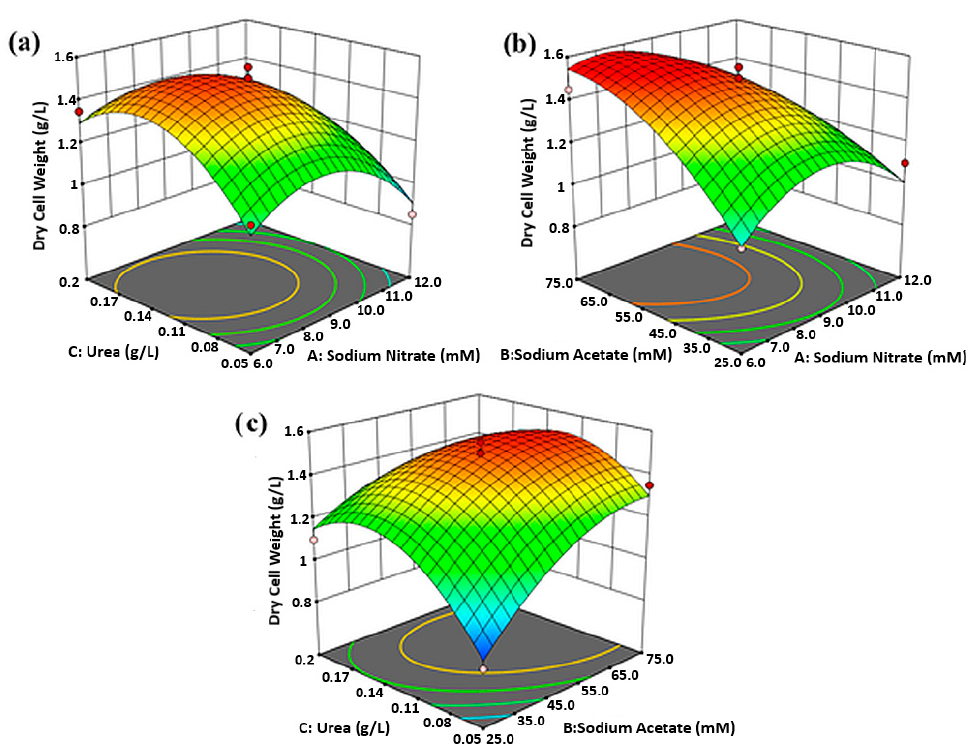
Figure 3. Response surfaces and contour plots showing the mutual effect of ( a ) urea and NaNO 3 , ( b ) sodium acetate and NaNO 3 , ( c ) urea and sodium acetate on C. vulgaris biomass density.